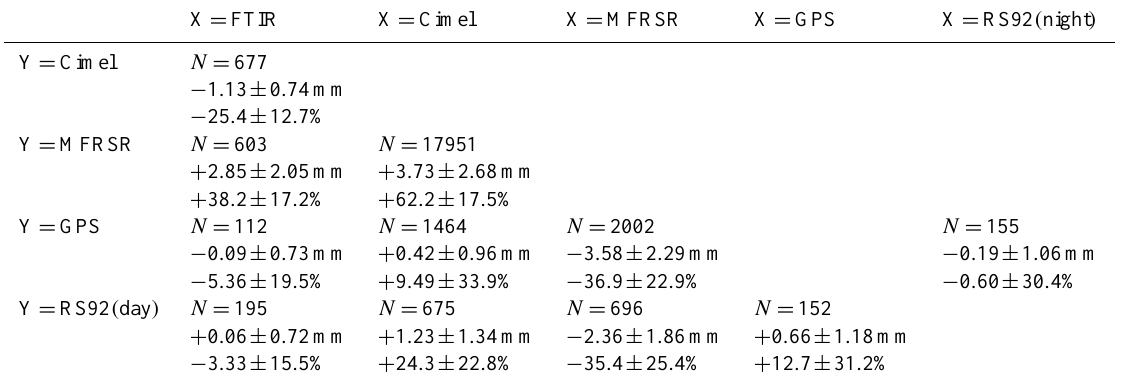
Fig. 5. Correlation of PWV measured by FTIR, Cimel, MFRSR, GPS and Vaisala RS92. The number of coincidences N and the correlation coefficients ρ are given in each panel. The blue line is the diagonal and the red dotted line is the linear regression line. Table 3. Results of intercomparison of different sensors: Number of coincidences ( N ), mean difference and standard deviation of difference in mm and % (2 × ( Y − X )/( X + Y )